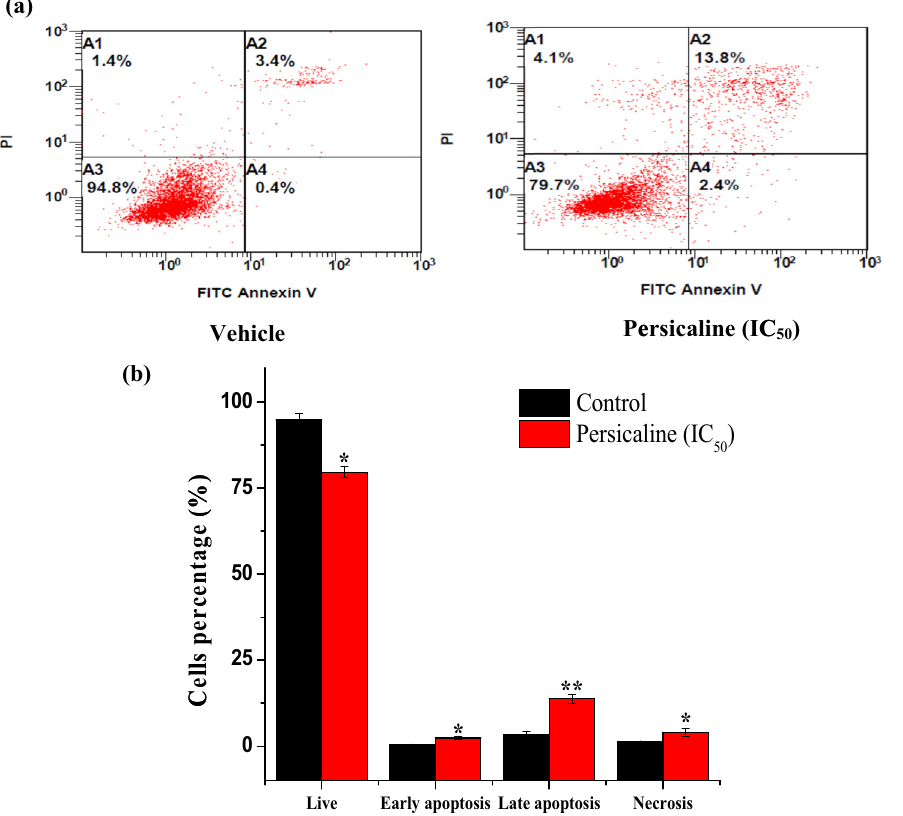
Figure 4: Persicaline - induced cell apoptosis of MCF - 7 evaluated by Annexin V - FITC/PI double staining assay. ( a ) Annexin V/PI staining representative dot plots: A4 ( early apoptosis ) , A3 ( live ) , A2 ( late apoptosis ) , and A1 ( necrosis ) . ( b ) Percentage column bar graph of total cell death. Data are shown as mean ± SD, ** p < 0.01 as compared to corresponding control.